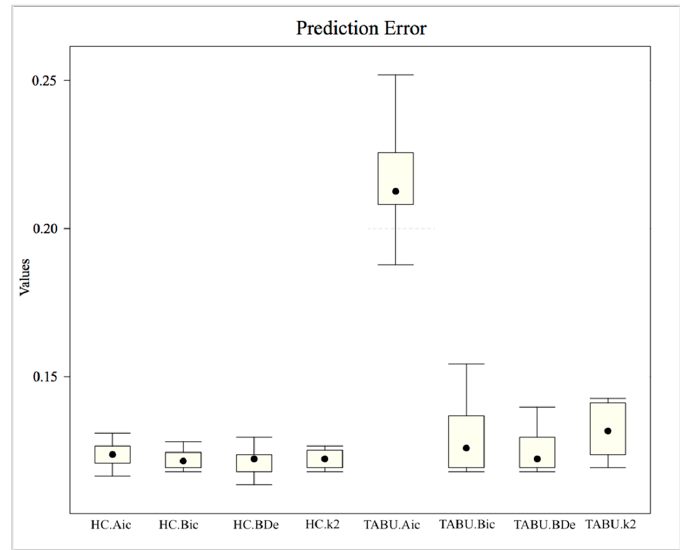
Figure 8. The predictive error of cross-validation using Bayesian posterior probability estimation.